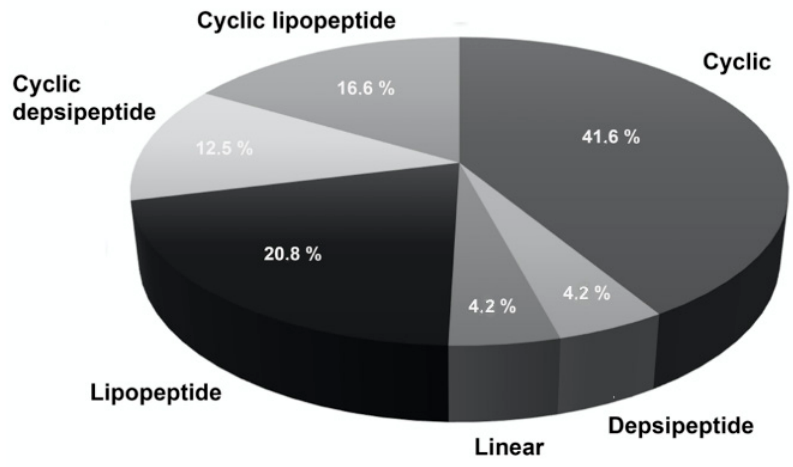
Figure 1. Di ff erent types of antibacterial peptides isolated from Figure 1. Different types of antibacterial peptides isolated from cyanobacteria.